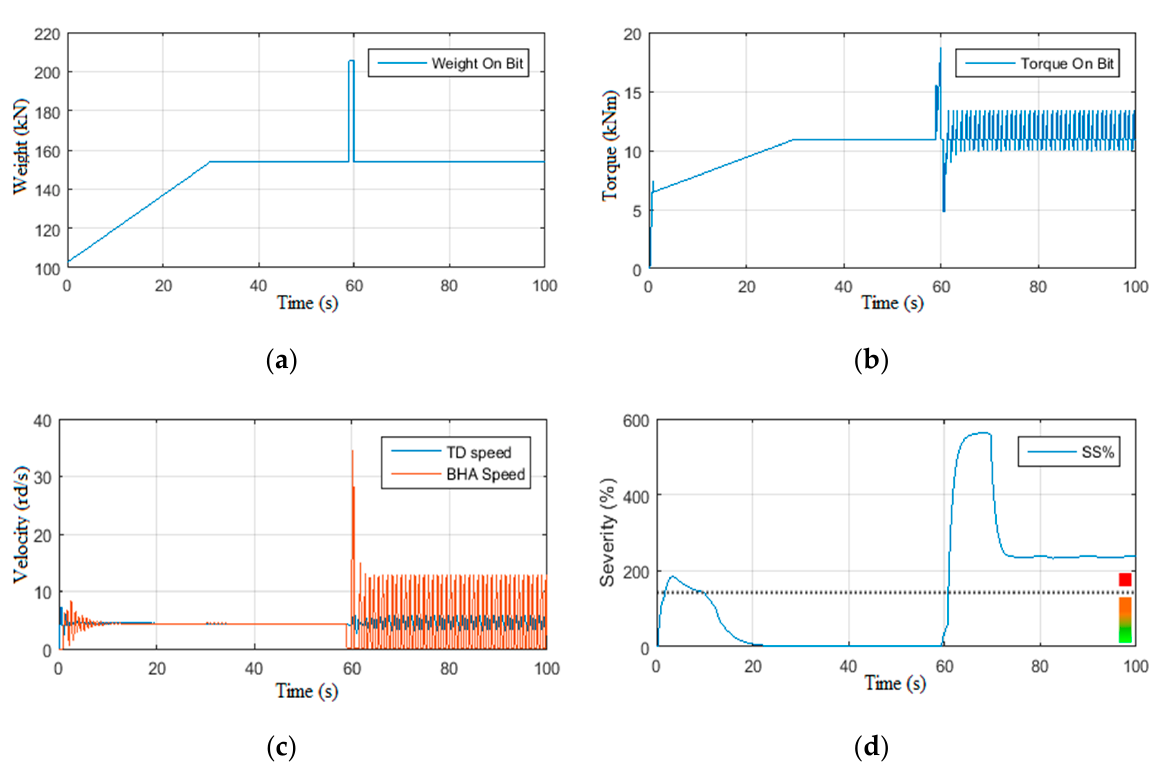
Figure 9. Responses of Scenario 2.2: ( a ) Weight on bit, ( b ) Torque on bit, ( c ) Rotational Velocities, ( d ) Stick-slip